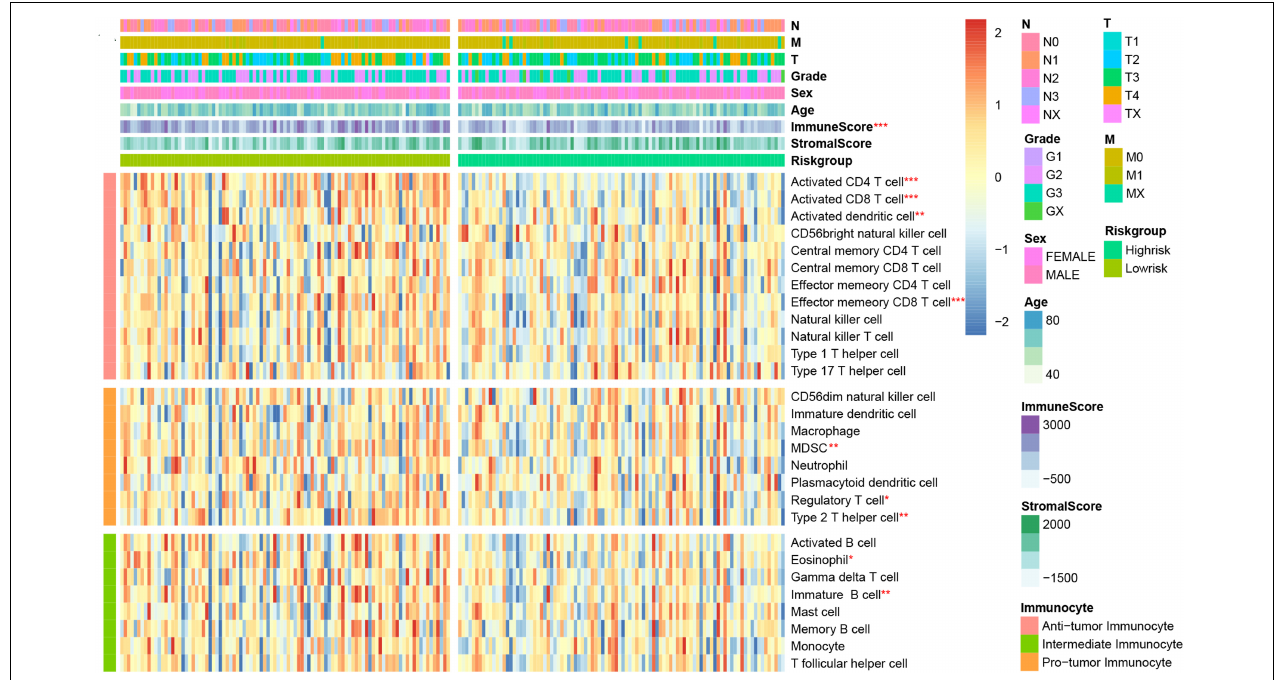
FIGURE 4 | Correlation between immune risk signature and immune cell infiltration. Single-sample gene set enrichment analysis (ssGESA) determined the relative abundance of 28 types of immune cell subpopulations with high- and low-risk signature subgroups. * P < 0.05, ** P < 0.01, and *** P < 0.001 (Mann–Whitney–Wilcoxon